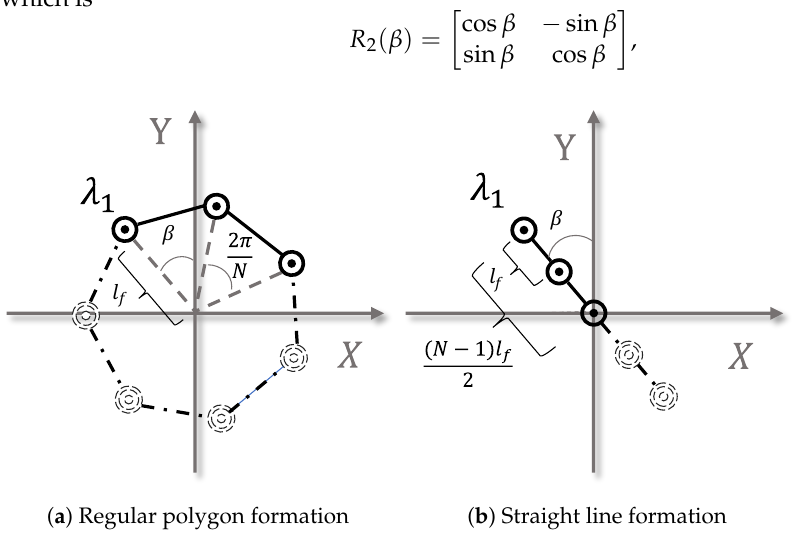
Figure 2. Two types of formation